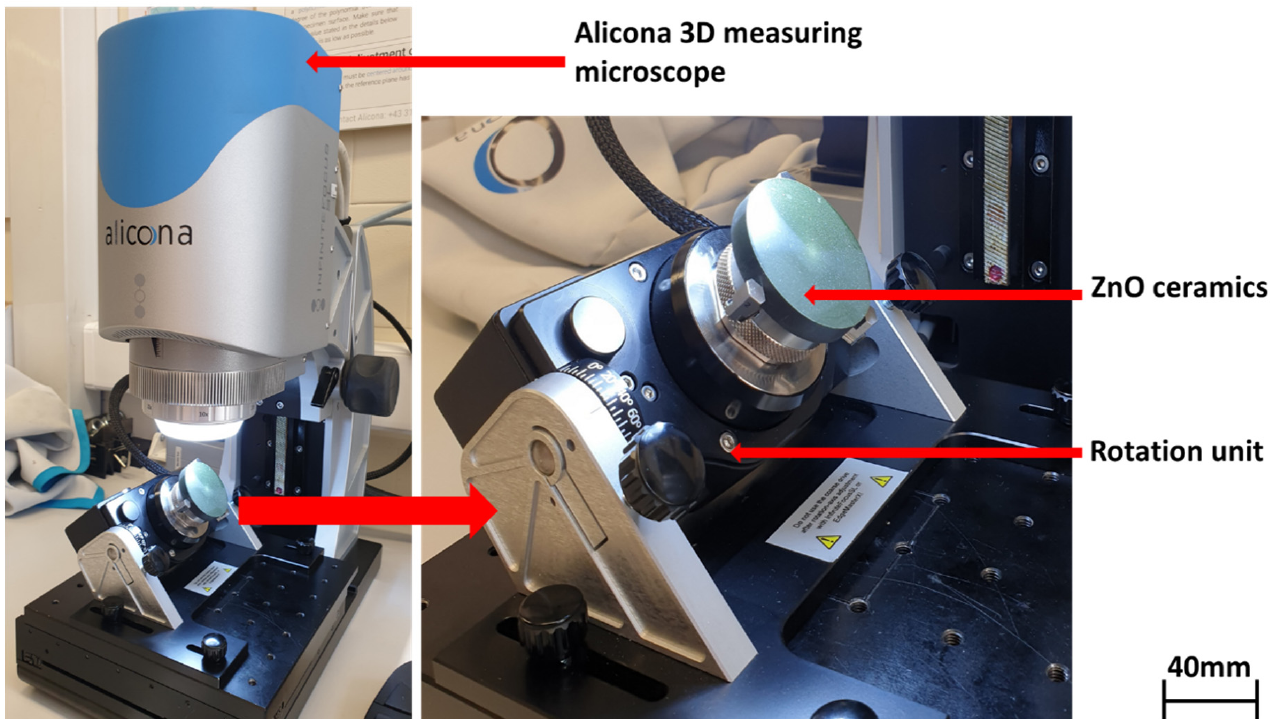
Figure 4. Surface roughness measurement setup with an Alicona 3D microscope. The non-contact profilometry (edge) for the quantification of the profile roughness was measured by utilizing the ISO 4287 and ISO 11562 standards in the Alicona three- dimensional measurement system. The R z (average peak to depression height of the roughness profile) parameter was chosen to characterize the profile radius and roughness. These values, accurate to two decimal places, were returned by the software after the development of profile plots from 100 points along the specified dimension. The surface roughness measurements under different feed velocities were measured on the top (marked red) and bottom (marked blue) sides of the machined ceramics, on randomly selected 5 mm long profiles in the x-axis direction. A repetition of the surface roughness measurements was considered along the y-axis approximately 10 µ m apart to obtain the mean